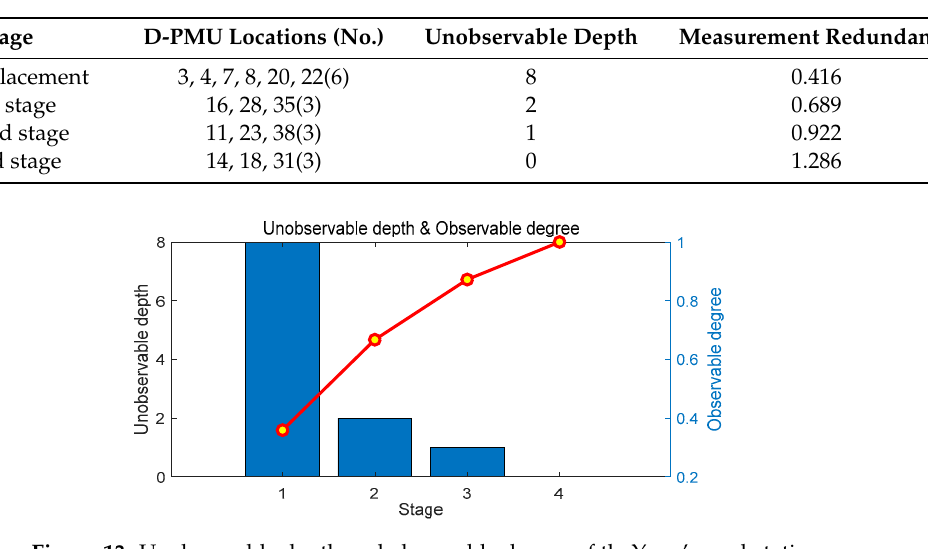
Table 6. The specific scheme of the Yuan'an station.